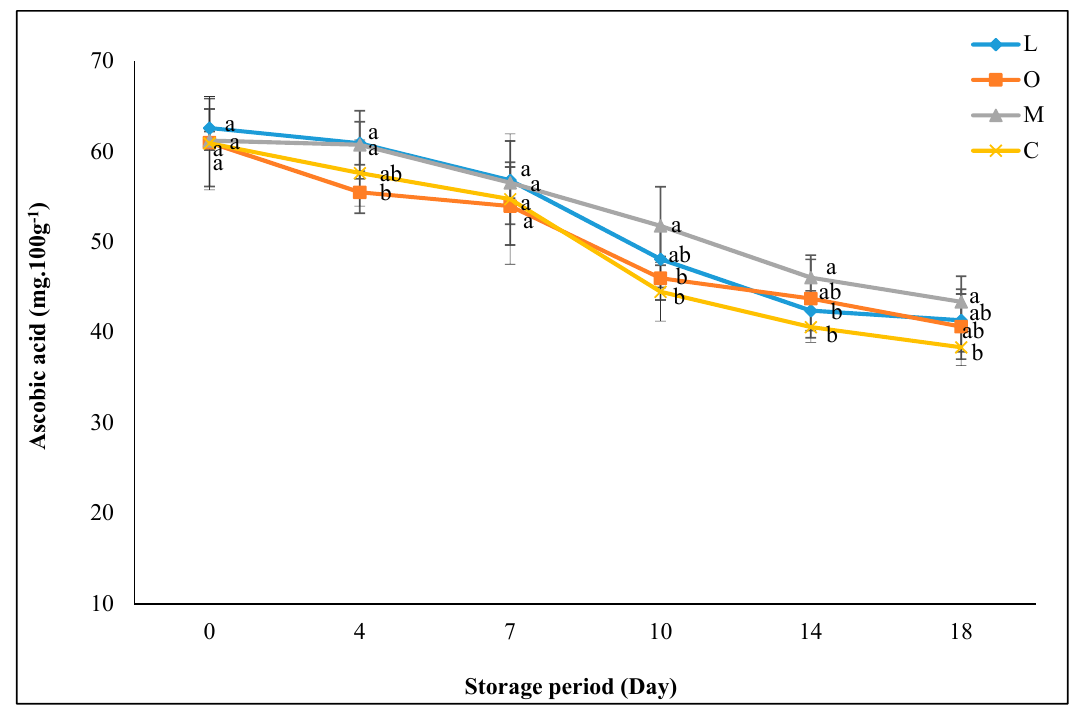
Figure 11. Effect of different essential oil emulsions (L = lemon, O = orange, and M = mandarin Figure 11. E ff ect of di ff erent essential oil emulsions (L = lemon, O = orange, and M = mandarin essential oil) on ascorbic acid of strawberry fruits stored at 2 °C for 18 days. Vertical bars indicate the essential oil) on ascorbic acid of strawberry fruits stored at 2 ◦ C for 18 days. Vertical bars indicate the standard deviation (n = 6). Means and different letters indicate significant difference between treated standard deviation (n = 6). Means and di ff erent letters indicate significant di ff erence between treated and control fruits at each storage period (Duncan’s of 95%). and control fruits at each storage period (Duncan’s of